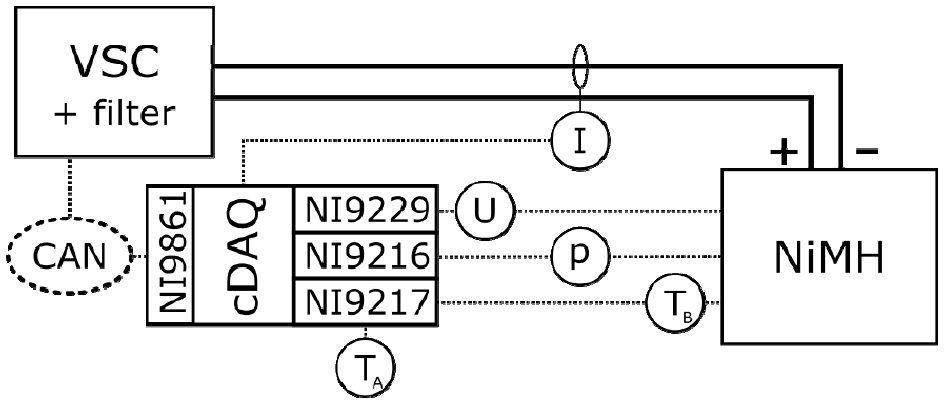
Figure 1. Schematic representation of the experimental setup. Numbers in cDAQ corresponds to used acquisition cards.